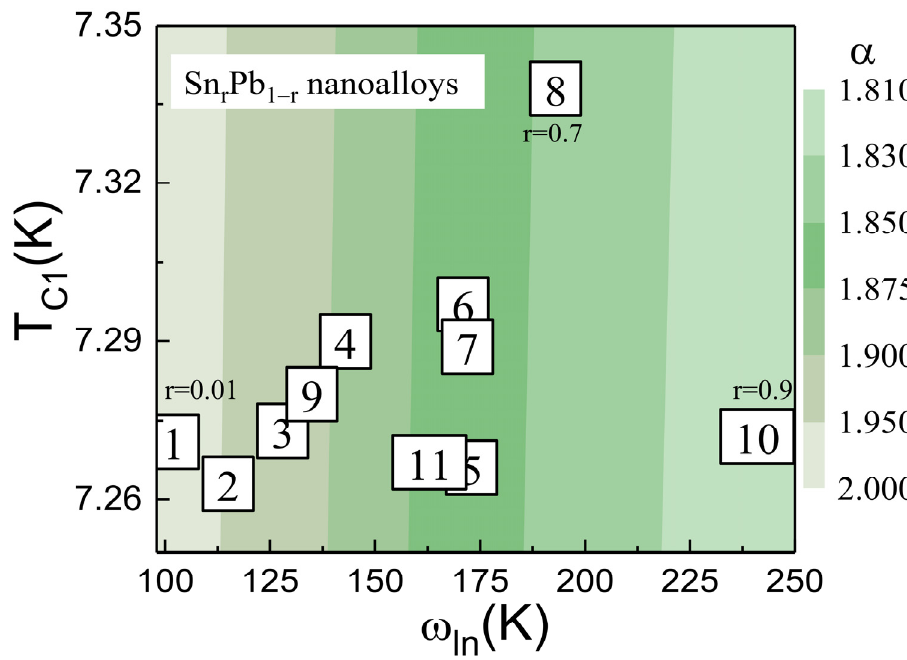
Figure 8. A 2D plot of observed T C versus estimated ω ln from the equation explained in the text where the various green colors represent weak-coupled strength α , respectively.